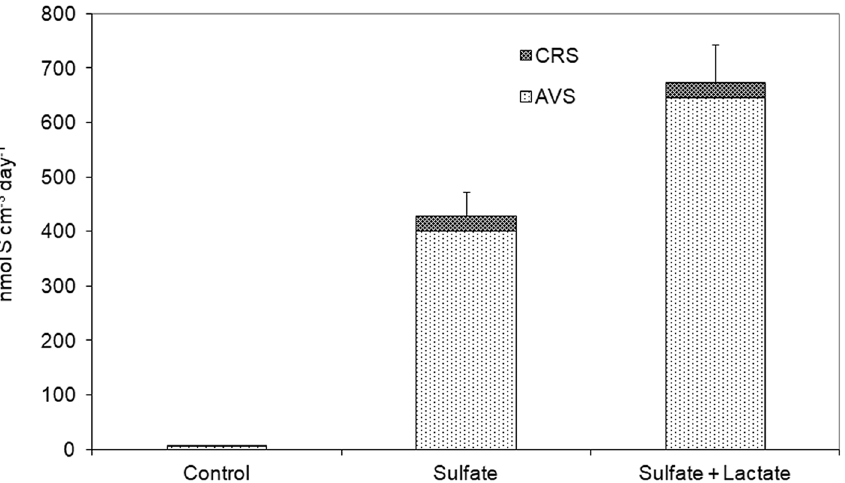
Figure 4. Sulfate reduction rate (SRR) and the amount of sulfur in acid volatile sulfides (AVS) and chromium- reducible sulfur (CRS) measured directly in the manure slurry (Tom3) without amendments (control), manure slurry supplemented with sulfate (Sulfate), and manure slurry supplemented with sulfate plus lactate (sulfate + lactate).